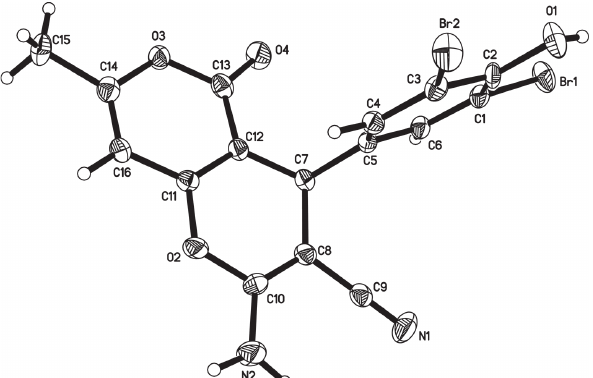
Table 2: Fractional atomic coordinates and isotropic or equivalent isotropic displacement parameters (Å 2